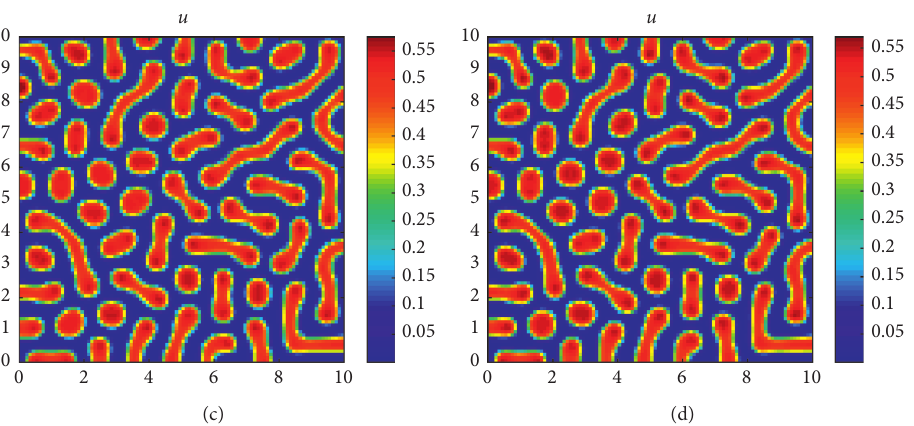
Figure 2: Mixture patterns obtained with model [1] for A � 0 . 02 and τ � 0. Time: (a) t � 100, (b) t � 500, (c) t � 2000, and (d) t �